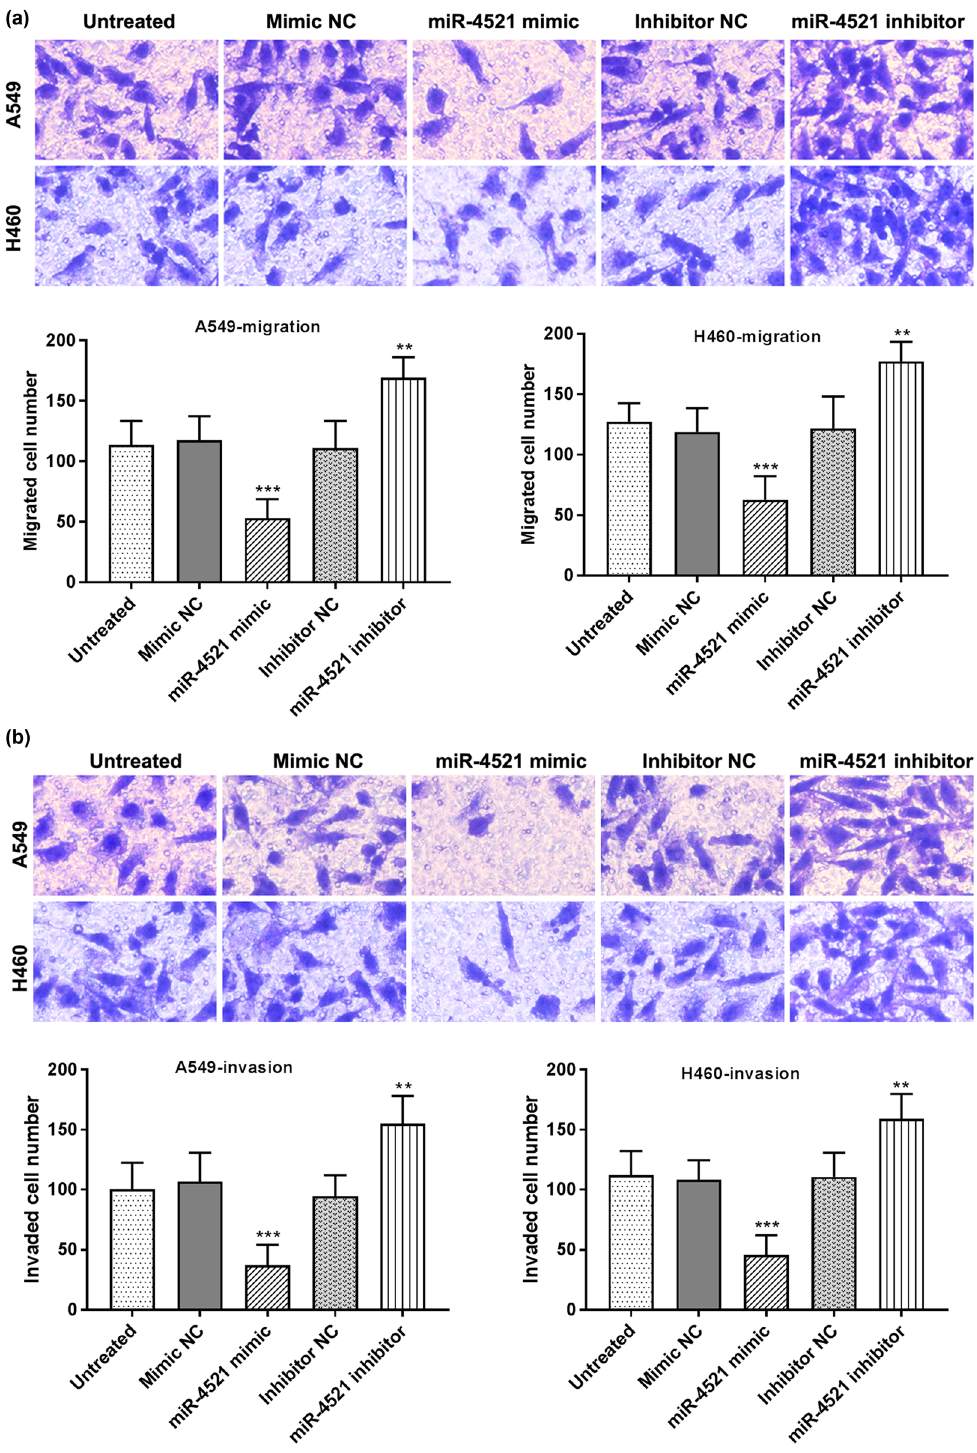
Figure 4: The e ff ect of miR - 4521 on cell migration and invasion. ( a ) miR - 4521 mimics inhibited the migration of A549 and H460 cells, while miR - 4521 inhibitors promoted cell migration ( magni fi cation × 200; ** P < 0.01, *** P < 0.001 ) . ( b ) miR - 4521 mimics inhibited the invasion ability of cells, while miR - 4521 enhanced the invasion ability of cells ( magni fi cation × 200; ** P < 0.01, *** P < 0.001 ) control group, the expression of miR - 4521 in NSCLC tis - analyzing the relationship between the expression of sues and cell lines was signi fi cantly downregulated. By miR - 4521 and the clinical characteristics of patients, it